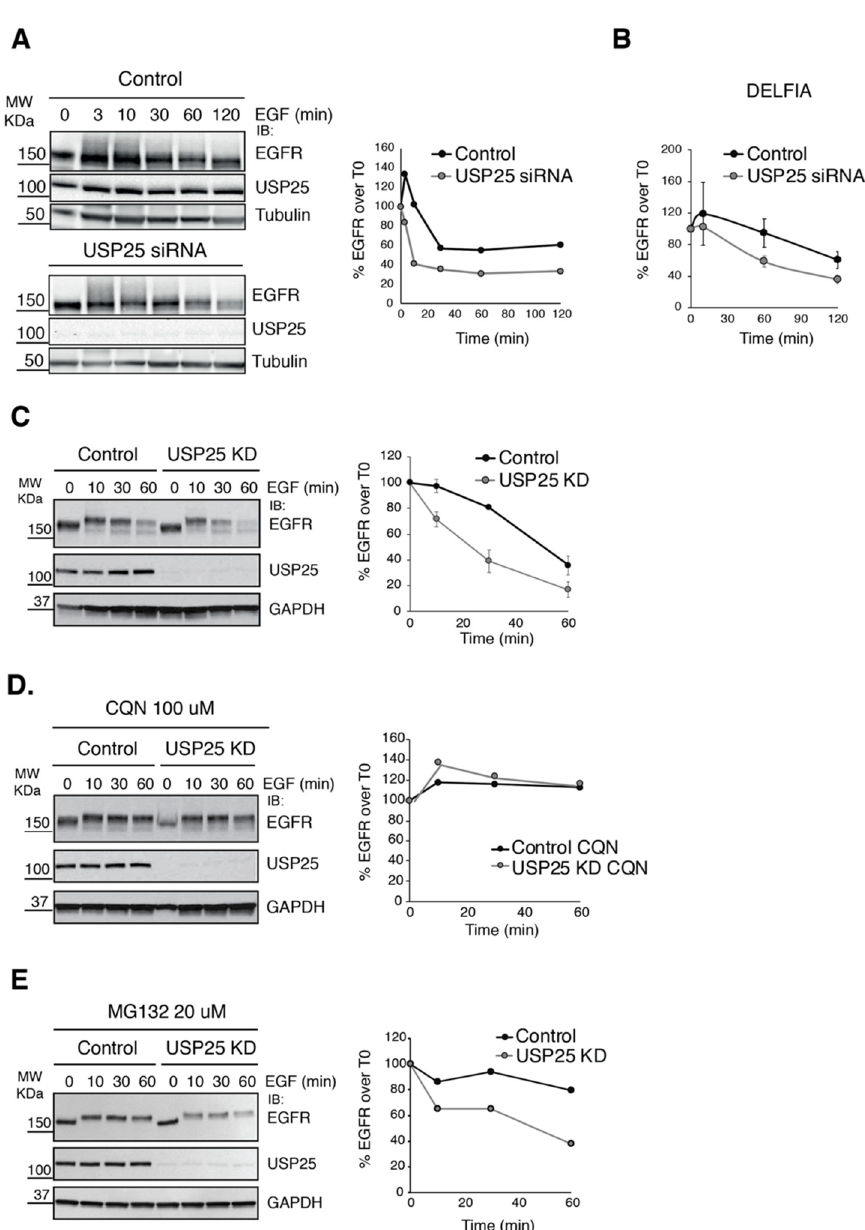
Figure 1. USP25 depletion induces a faster degradation of the EGFR. ( A , B ) Immunoblot (IB) and DELFIA analyses of HeLa cells transiently transfected with a RNAi oligo targeting USP25 or a scramble oligo (control). Serum-starved cells were stimulated with EGF (100 ng / mL), as indicated, and total cell lysates were analyzed by IB ( A , left panel, one representative experiment of three is shown) and DELFIA ( B ) as indicated. ( C , left panel) IB analysis, as in A, of a stable HeLa cell line carrying a shRNA targeting USP25 and control cells. USP25 depletion was induced with doxycycline treatment (0.5 µ g / mL). One representative experiment of three is shown. ( D , E , left panels) IB analysis of cells as in C, but pre-treated with Chloroquine (CQN 100 µ M) for 1 h ( D ) or MG132 (20 µ M) for 2 h ( E ) before stimulation with EGF. ( A , C – E ) Right panels: quantification of percentage EGFR signal, using the immunoblots.